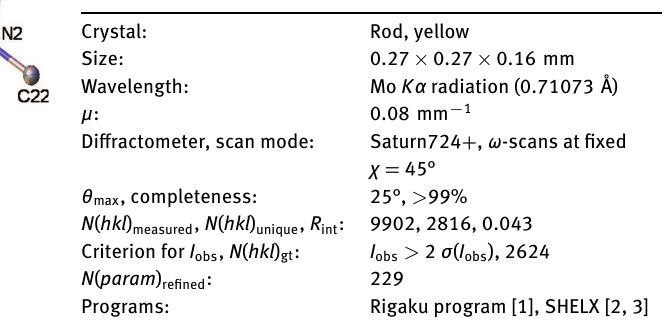
Table 1: Data collection and handling.